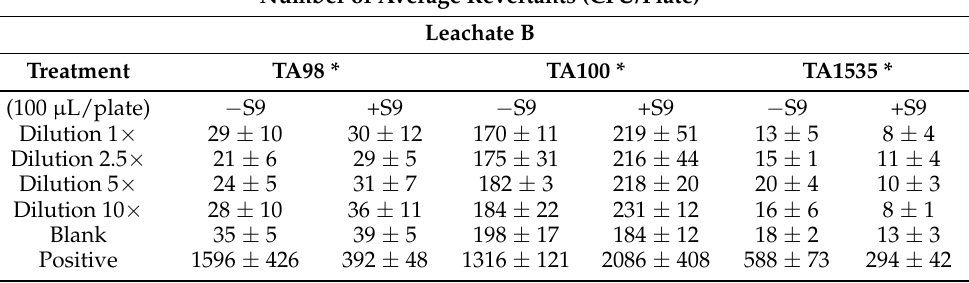
Table 3. Revertant frequency of Salmonella tester strains TA98, TA100, and TA1535 following incubation with leachate B from BFA in presence and absence of S9 mix (mean ± SD is shown).